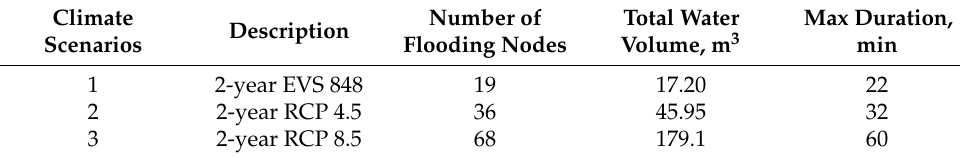
Table 2. Flooding indicators for different scenarios in